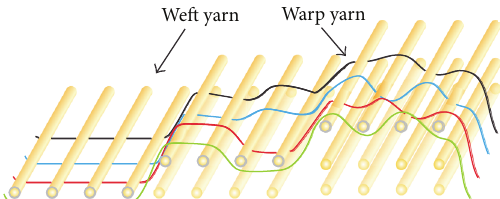
Figure 1: Schematic diagram of the original biomimic thermal fabric